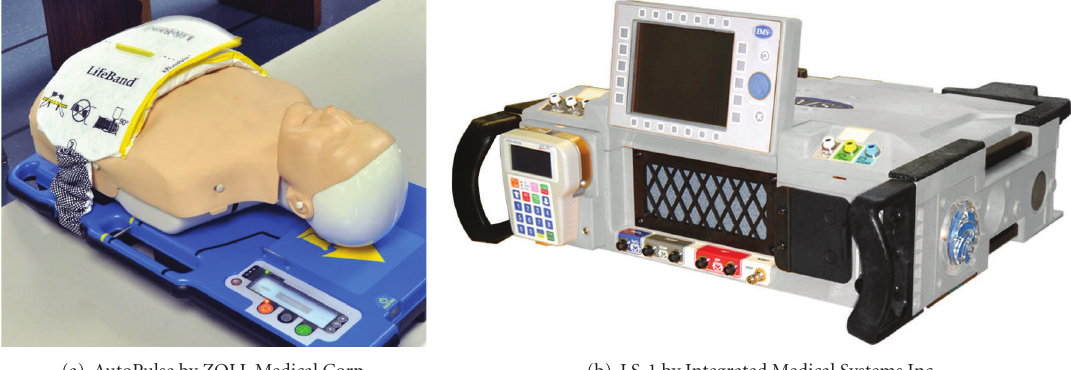
Figure 6: Commercially available Emergency Response robots perform simple actuations compared to robots in other medical disciplines, but their actions are tightly coupled with patient measurements. The AutoPulse image is ©2012 ZOLL Medical Corp. The LS-1 image is ©2012 Integrated Medical Systems